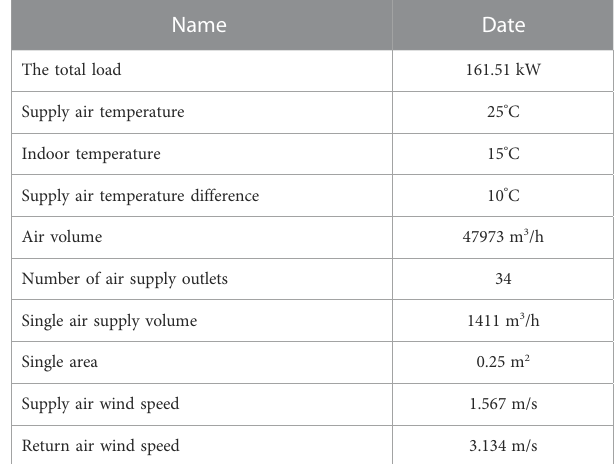
TABLE 3 Air supply design